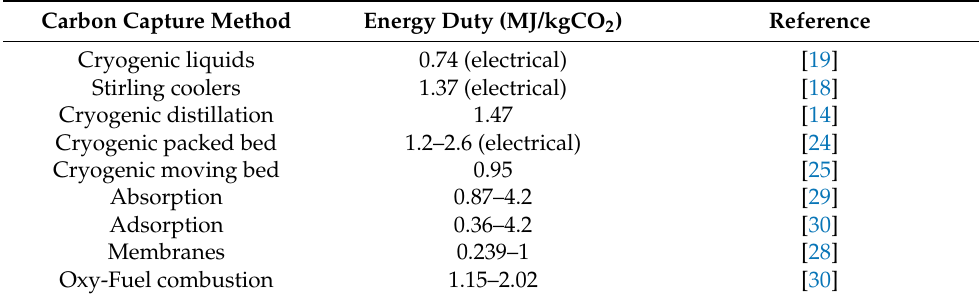
Table 2. Comparison of energy duties for various carbon capture